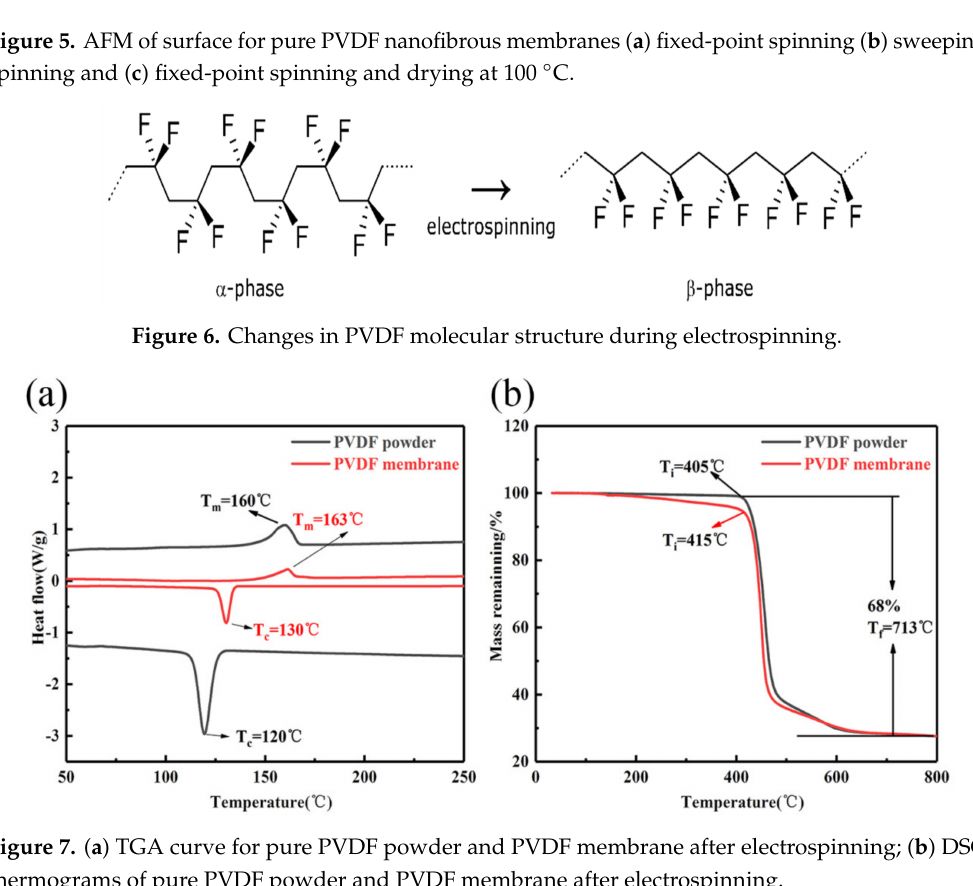
Figure 7. ( a ) TGA curve for pure PVDF powder and PVDF membrane after electrospinning; ( b ) DSC thermograms of pure PVDF powder and PVDF membrane after